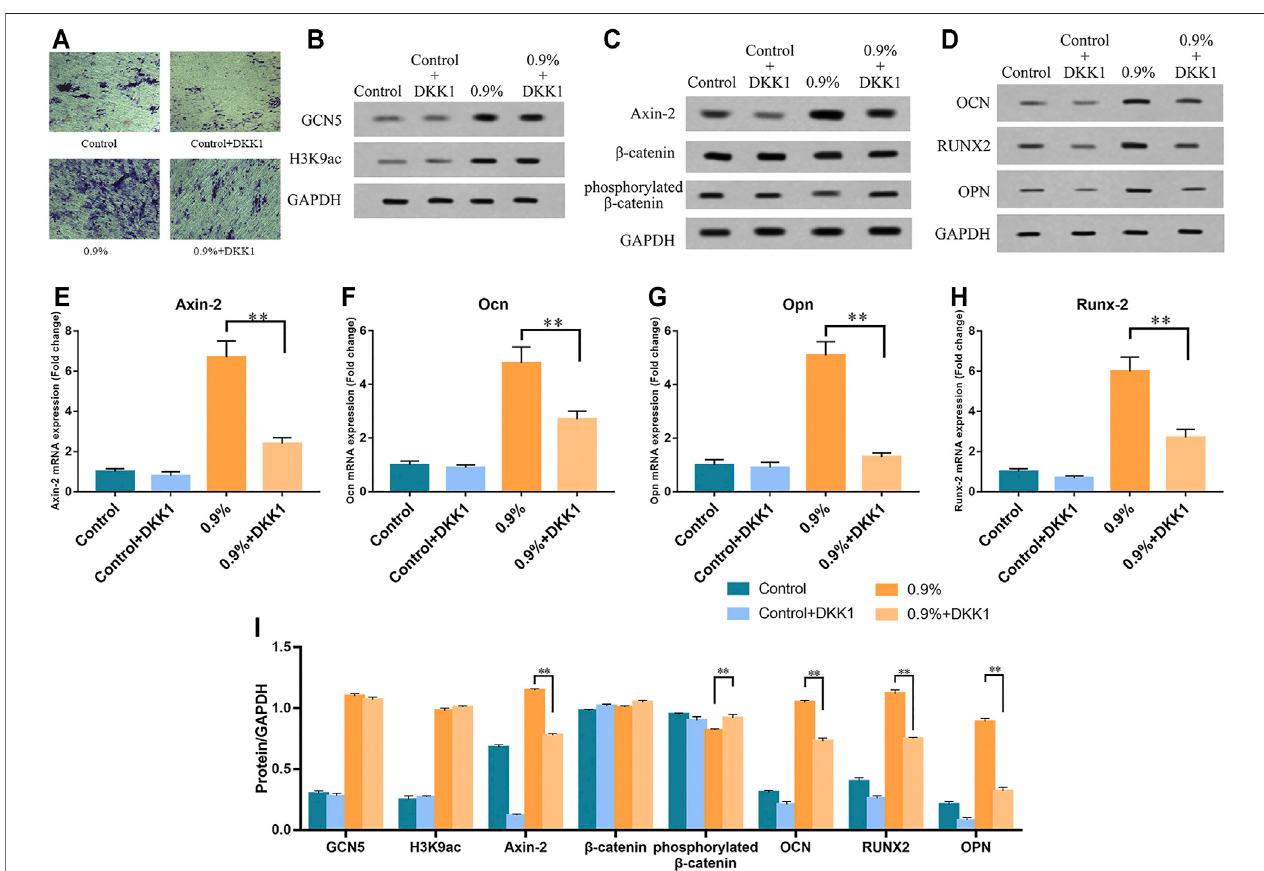
FIGURE 7 | DKK1 inhibited the activity of Wnt/ β -catenin signaling pathway and osteogenic differentiation of BMSCs but showed no effect on the expression of GCN5 and H3K9 acetylation modi fi cation. (A) ALP activity in BMSCs with DKK1 treatment and non – DKK1 treatment. Scale bars: 500 μ m. (B) Western blots of GCN5 and H3K9ac. (C) Western blots of Axin-2, phosphorylated β -catenin, and β -catenin. (D) Western blots of Ocn, Opn, and Runx2 in BMSCs with DKK1 treatment and non – DKK1 treatment. (E – H) The mRNA expression of Axin-2, Ocn, Opn, and Runx2 in BMSCs with DKK1 treatment and non – DKK1 treatment. (I) Semi- quantitative and statistical analyses of the results in Panels B – D . Values are plotted as mean ± SD, * p < 0.05, ** p < 0.01.